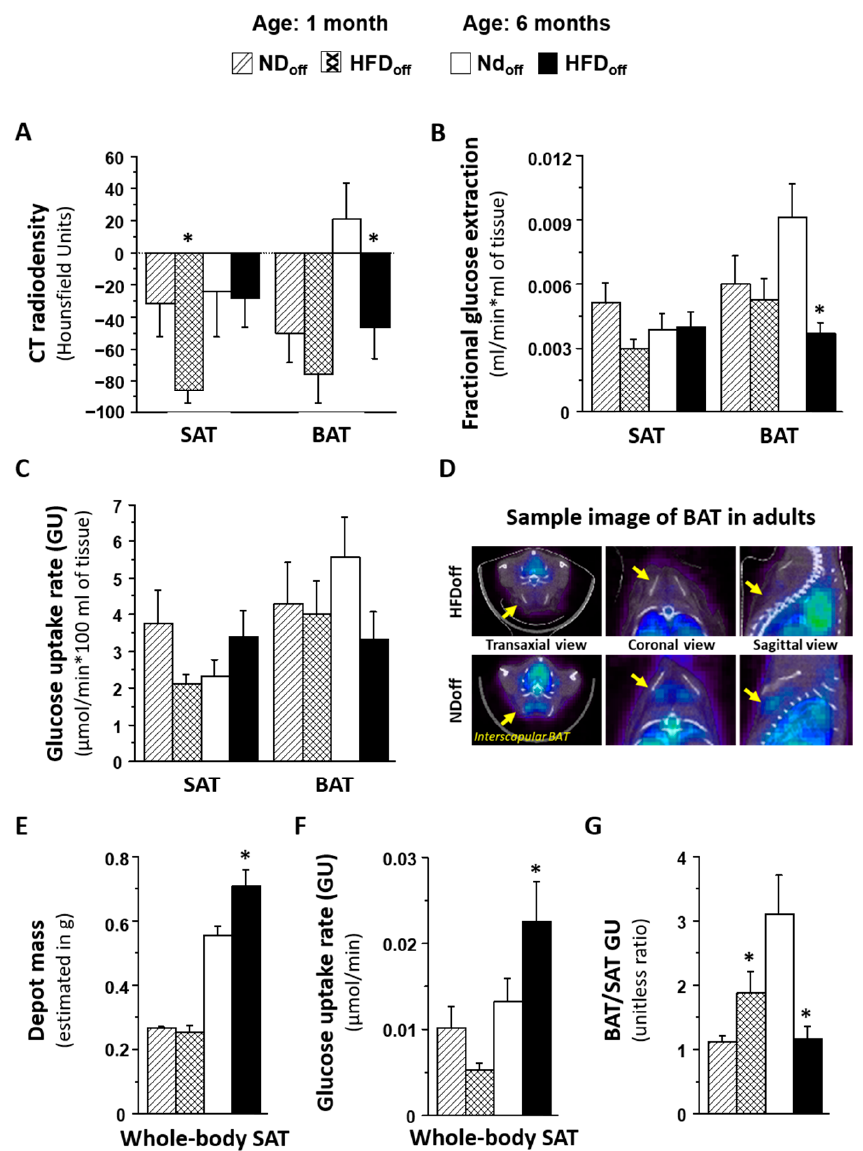
Figure 1. Phenotype of mice born to HFD or ND dams, including BAT and SAT lipid content ( A ), given by negative values in CT radiodensity, glucose metabolism ( B – D ) by PET imaging, features of whole-body SAT ( E , F ), and the metabolic balance between BAT and SAT ( G ), in early and adult life. The sample images in D shows interscapular BAT 18 FDG levels (Bq/mL) in transaxial, coronal, and sagittal views, in two representative cases (HFDoff: fractional extraction rate constant = 0.003 mL/min, GU = 2.4 µ mol/min * 100 mL; NDoff: fractional extraction rate constant = 0.013 mL/min, GU = 9.4 µ mol/min * 100 mL). * p < 0.05 vs. age-matched NDoff group. NDoff = offspring born to ND dams; HFDoff = offspring born to HFD dams.